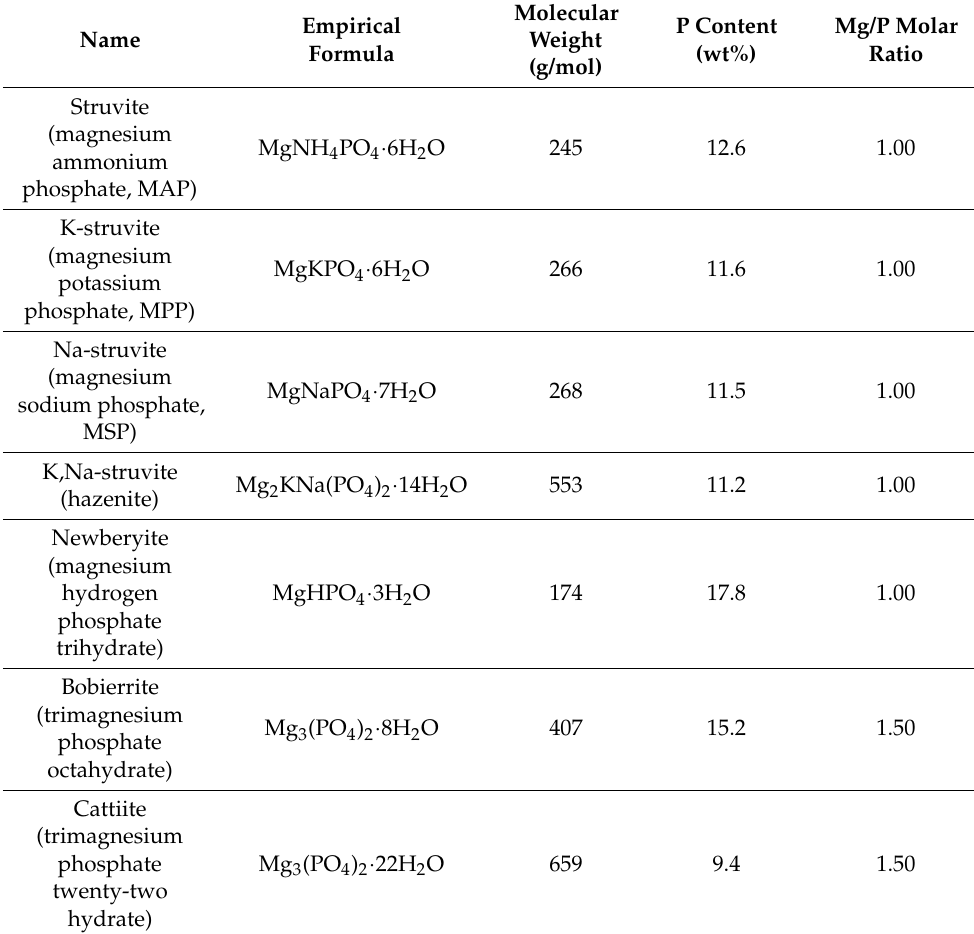
Table 1. Magnesium phosphate (MgP) minerals formable in wastewater crystallization